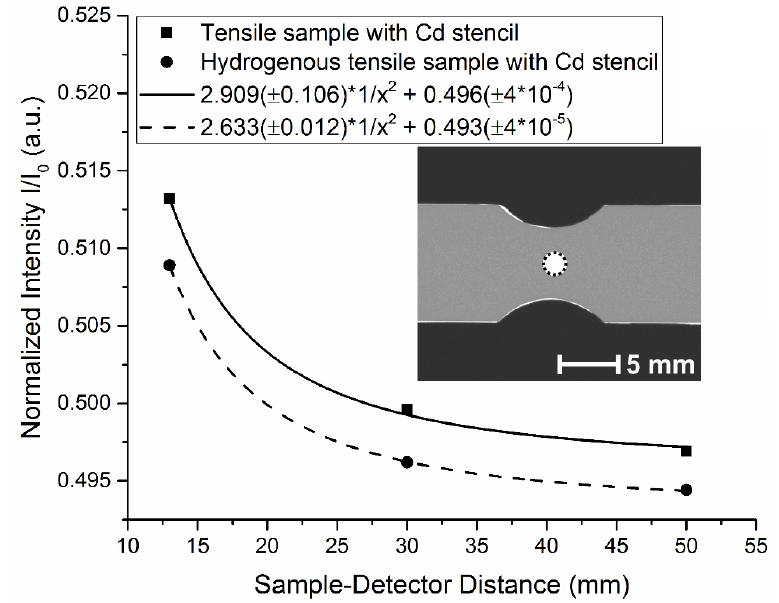
Figure 4. Normalized intensity for three sample-detector distances (13, 30 and 50 mm) for a flat bar tensile test specimen framed by a Cd stencil. The circle in the middle of the sample radiograph denotes the chosen ROI. The fitted curves describe an inverse-square law function of the distance.